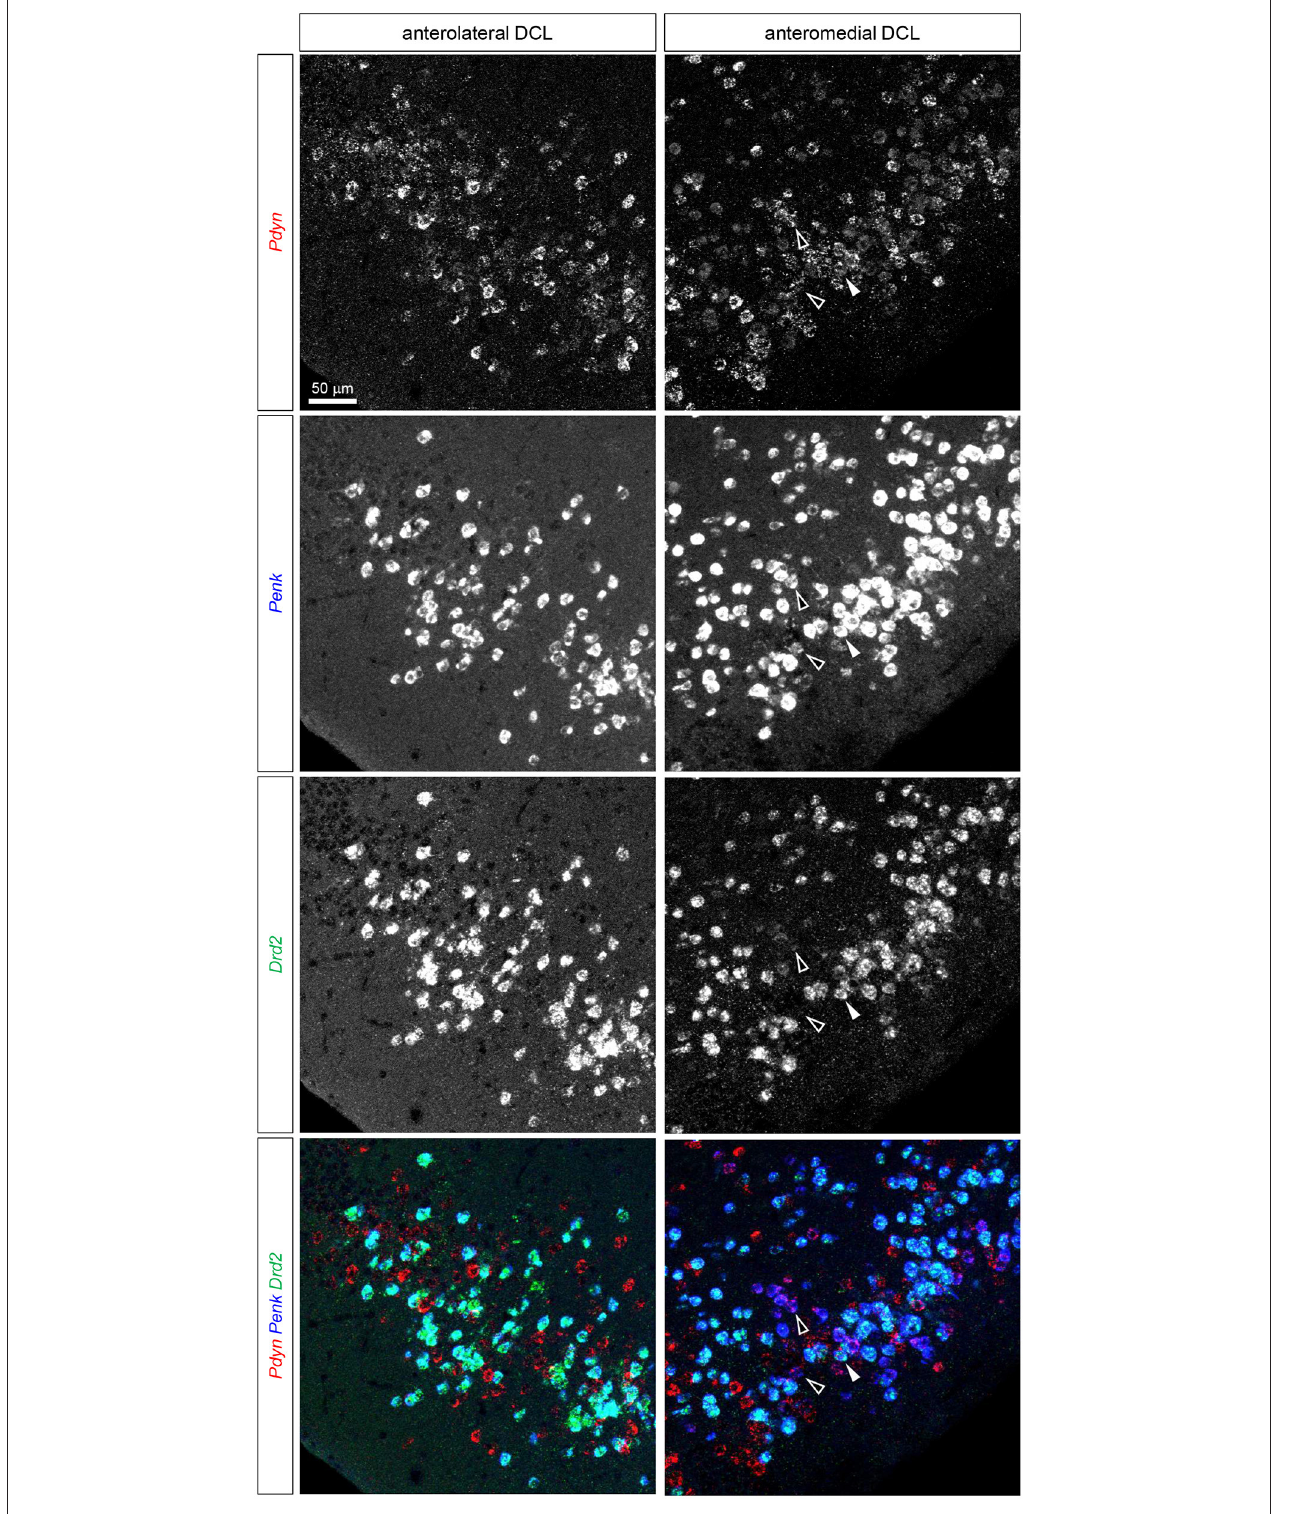
FIGURE 5 | Triple fluorescence ISH for and Pdyn-Penk-Drd2 mRNAs in the anteromedial and anterolateral OT DCL. Fluorescence images of Pdyn (red), Penk (blue), and Drd2 (green) mRNA signals in the same region. A white arrowhead shows the colocalization of the Pdyn-Penk-Drd2 mRNAs. White-outlined arrowheads indicate the colocalization of Pdyn-Penk signals, which did not colocalize with Drd2 signals. Right panels, anteromedial DCL; left panels, anterolateral DCL.